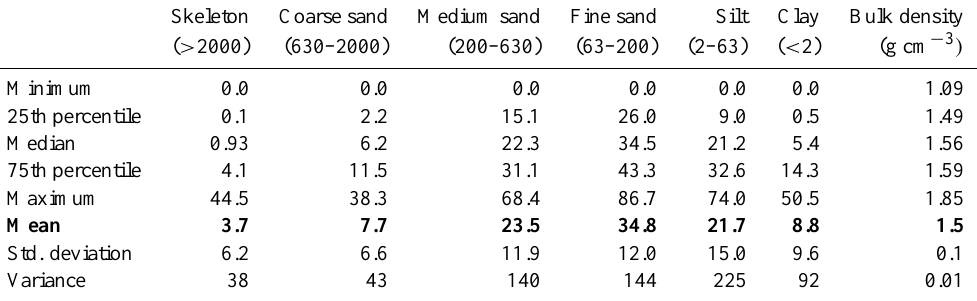
Table 7. Statistical values for particle size distributions (in %) and bulk density after linear interpolation (Discrete Smooth Interpolation, DSI). Size intervals are given in µm. The volume of interest (eastern part of the catchment) contained 230587